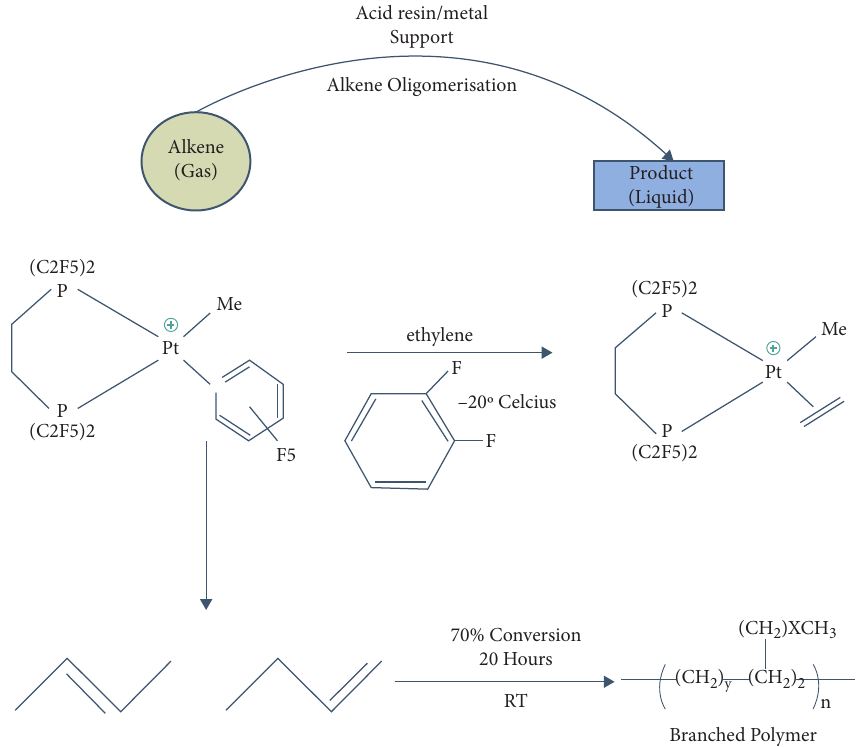
Figure 1: Mechanism of alkene